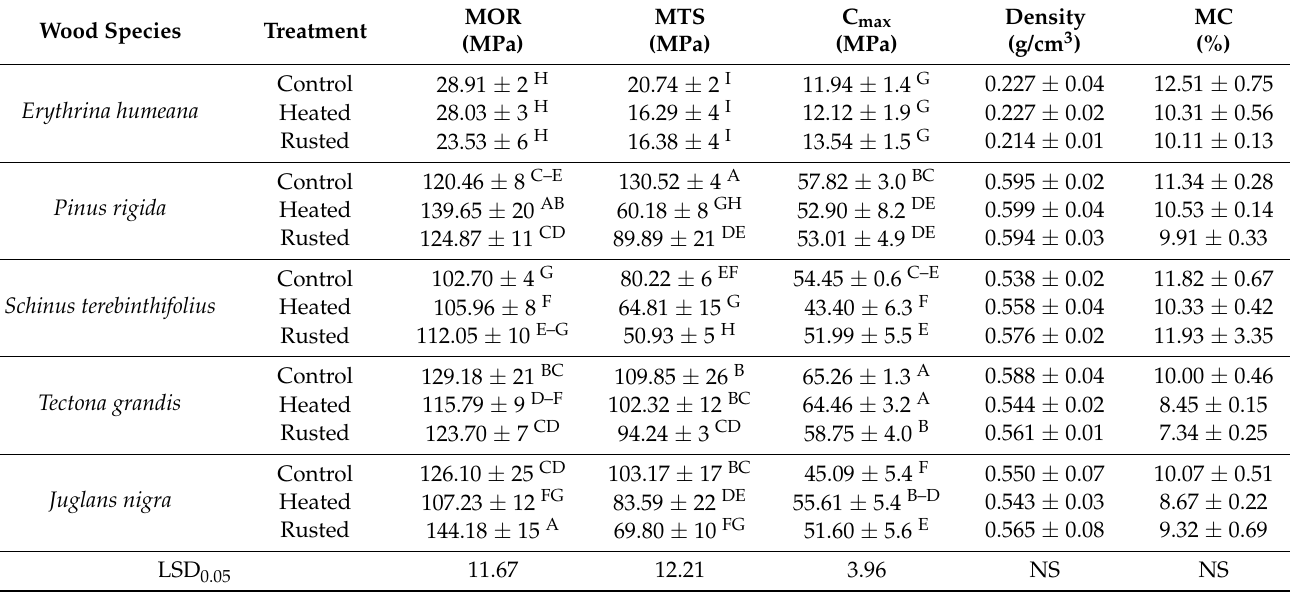
Each value is an average of three samples. C max = the compression strength parallel to grain (MPa) at about 12% moisture content, MTS, maximum tensile strength. Means with the letter/s within the same column are not significantly different according to LSD